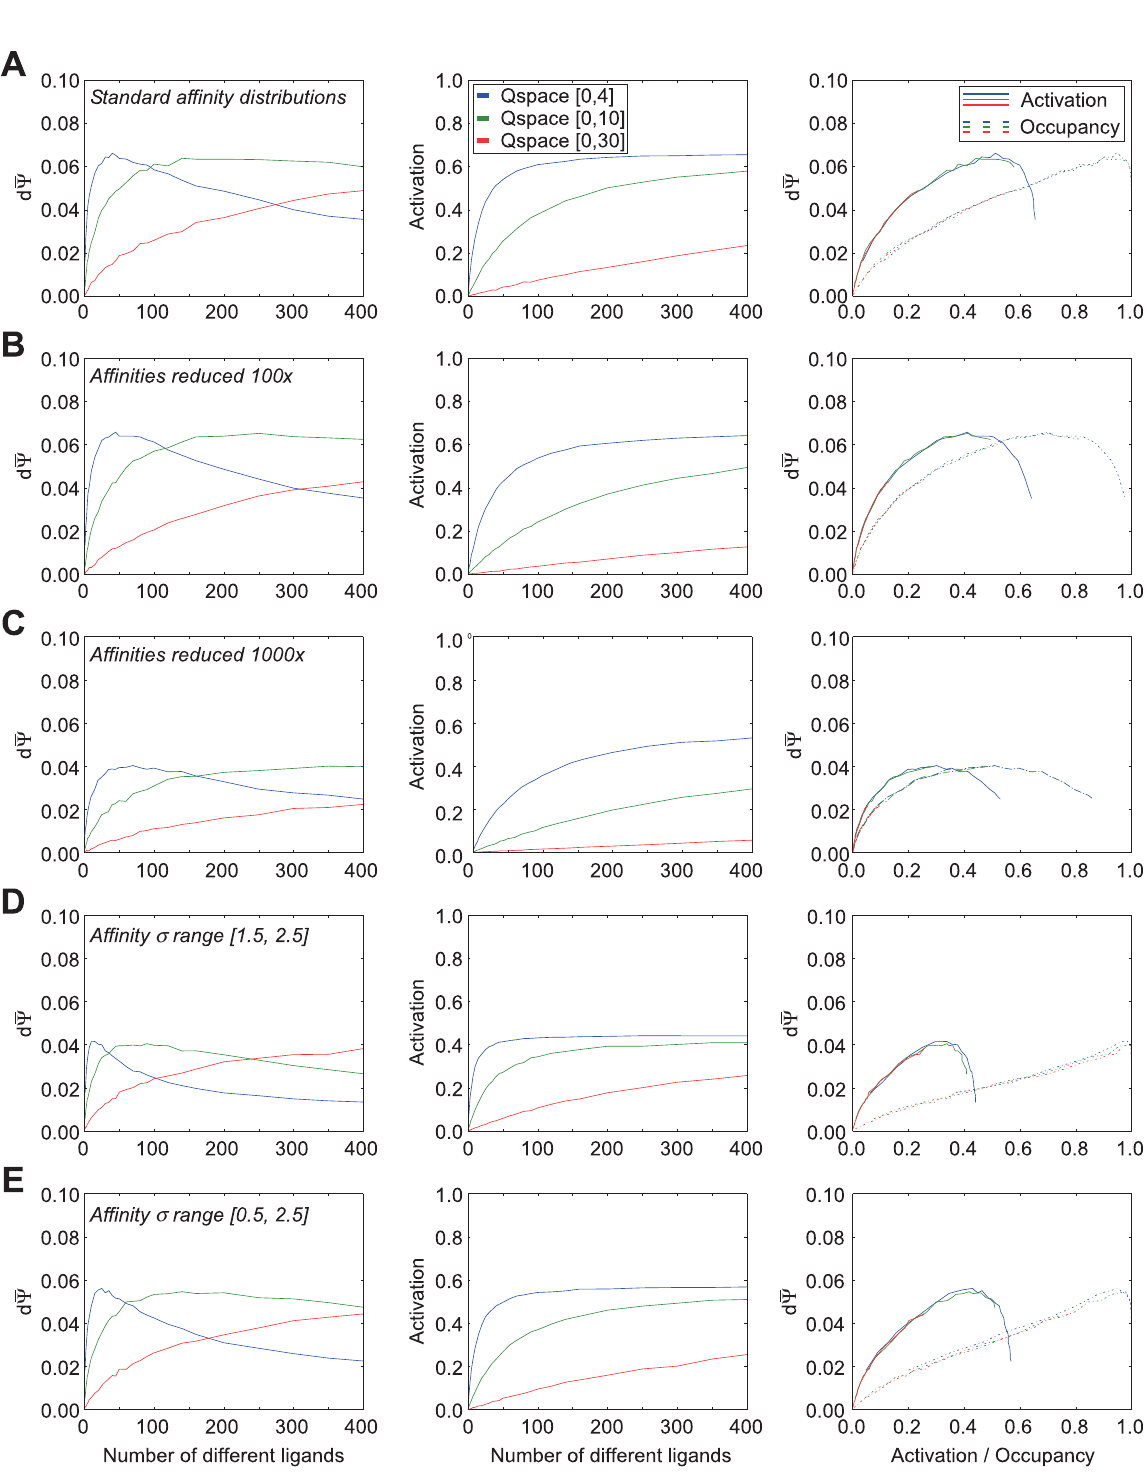
Fig 5. Effects of ligand and receptor densities on receptor activation/occupancy and discrimination capacity, while drawing receptor efficacy Gaussian standard distributions from the standard range of σ = [0.05, 1.0] q-units. Thirty receptors were deployed into each of three different Q-spaces. A. Using the standard distribution of affinity Gaussians ( σ = [0.5, 1.5]), the mean discrimination capacity ( left panel ) and receptor occupancy ( center panel ) were measured as functions of the number of ligands deployed in the space; the two functions also were plotted against one another ( right panel ). B. As panel A, but with affinities uniformly reduced by two orders of magnitude (Gaussian peak affinity K d = 10 − 6 M, asymptotic affinity K d = 10 +4 M). C. As A, but with affinities reduced by three orders of magnitude (Gaussian peak